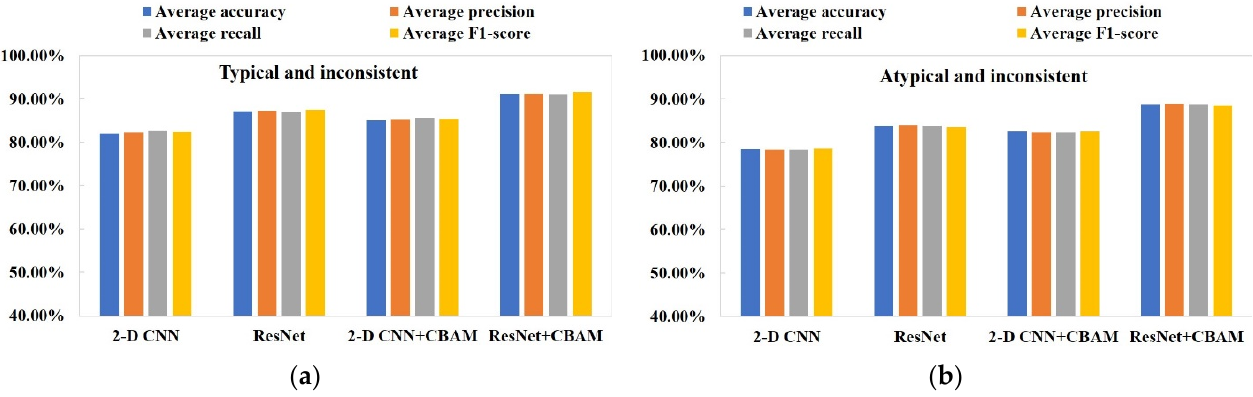
Figure 13. Performance comparison of the 2 ‐ D CNN, ResNet, 2 ‐ D CNN+CBAM, and ResNet+CBAM with the ( a ) typical and inconsistent and ( b ) atypical and inconsistent data sets in Table 6.